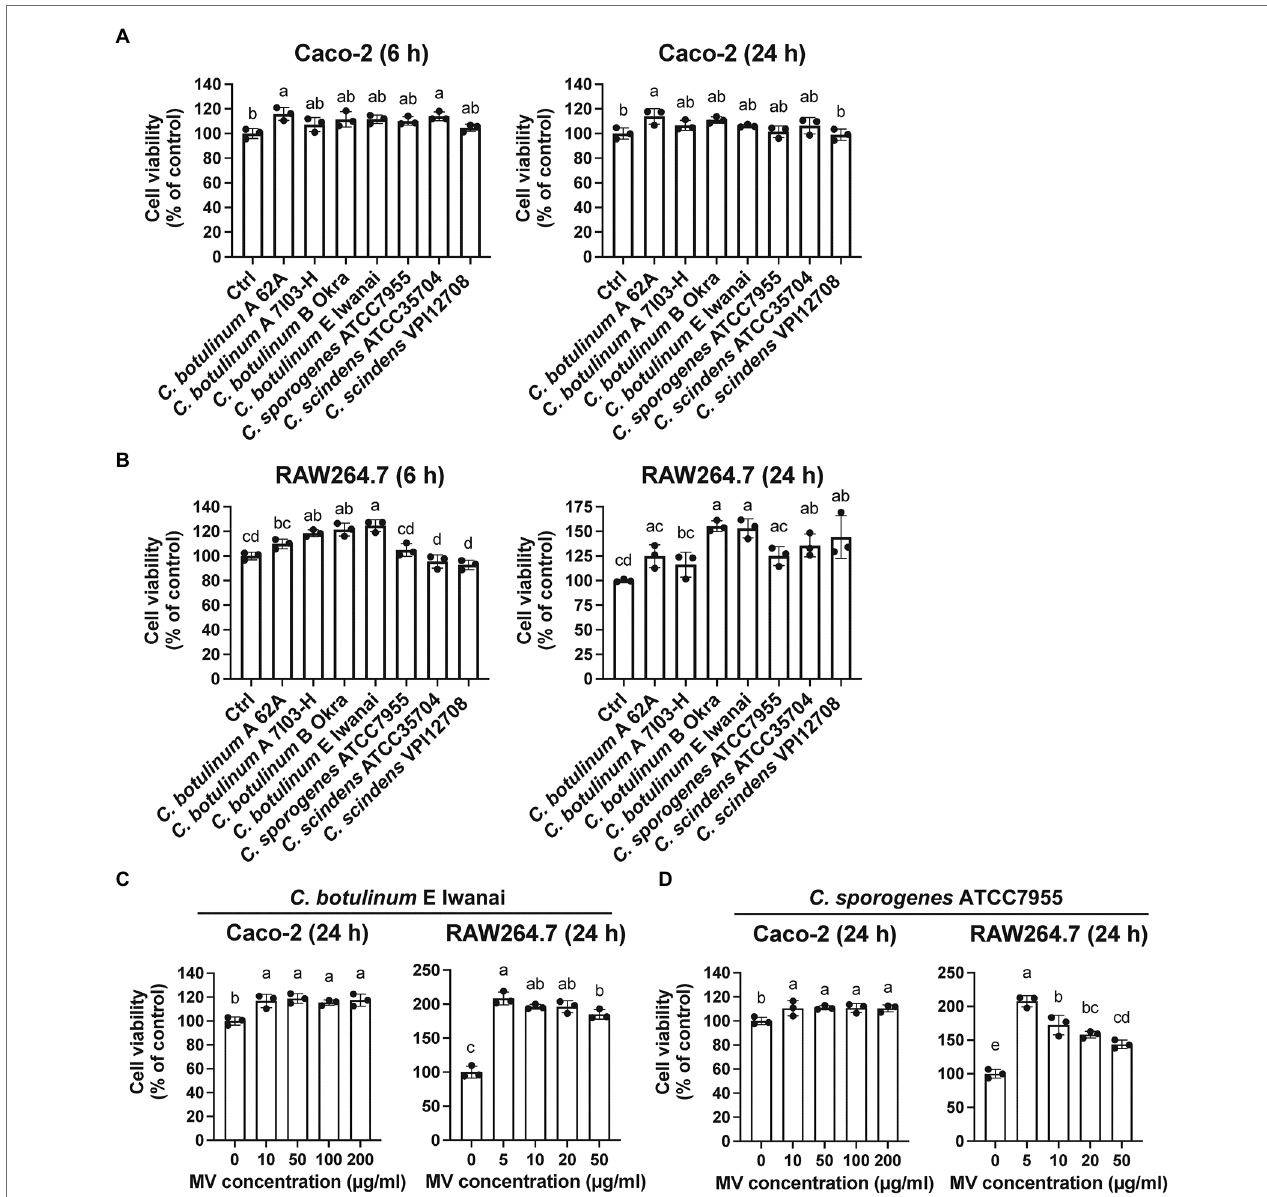
FIGURE 3 | Cytotoxicity of clostridial MVs in (A) Caco-2 and (B) RAW264.7 cells. Cells were treated with 10 or 50 μ g/ml MVs for 6 or 24 h. Cell viability was evaluated by measuring intracellular dehydratase activity. (C) Cells were treated with the different doses of MVs (0–200 μ g/ml for Caco-2 and 0–50 μ g/ml for RAW264.7) derived from C. botulinum type E Iwanai and (D) C. sporogenes ATCC7955 for 24 h. Error bars indicate SD. Means that do not share a letter are significantly different ( p < 0.05). n = 3, a one-way ANOVA with Tukey’s multiple comparisons post hoc test. Data are representative of two independent